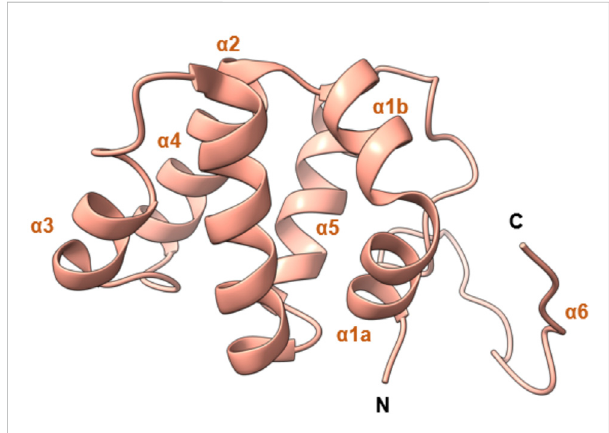
FIGURE 2 NMR solution structure of human RIPK2 CARD (PDB ID: